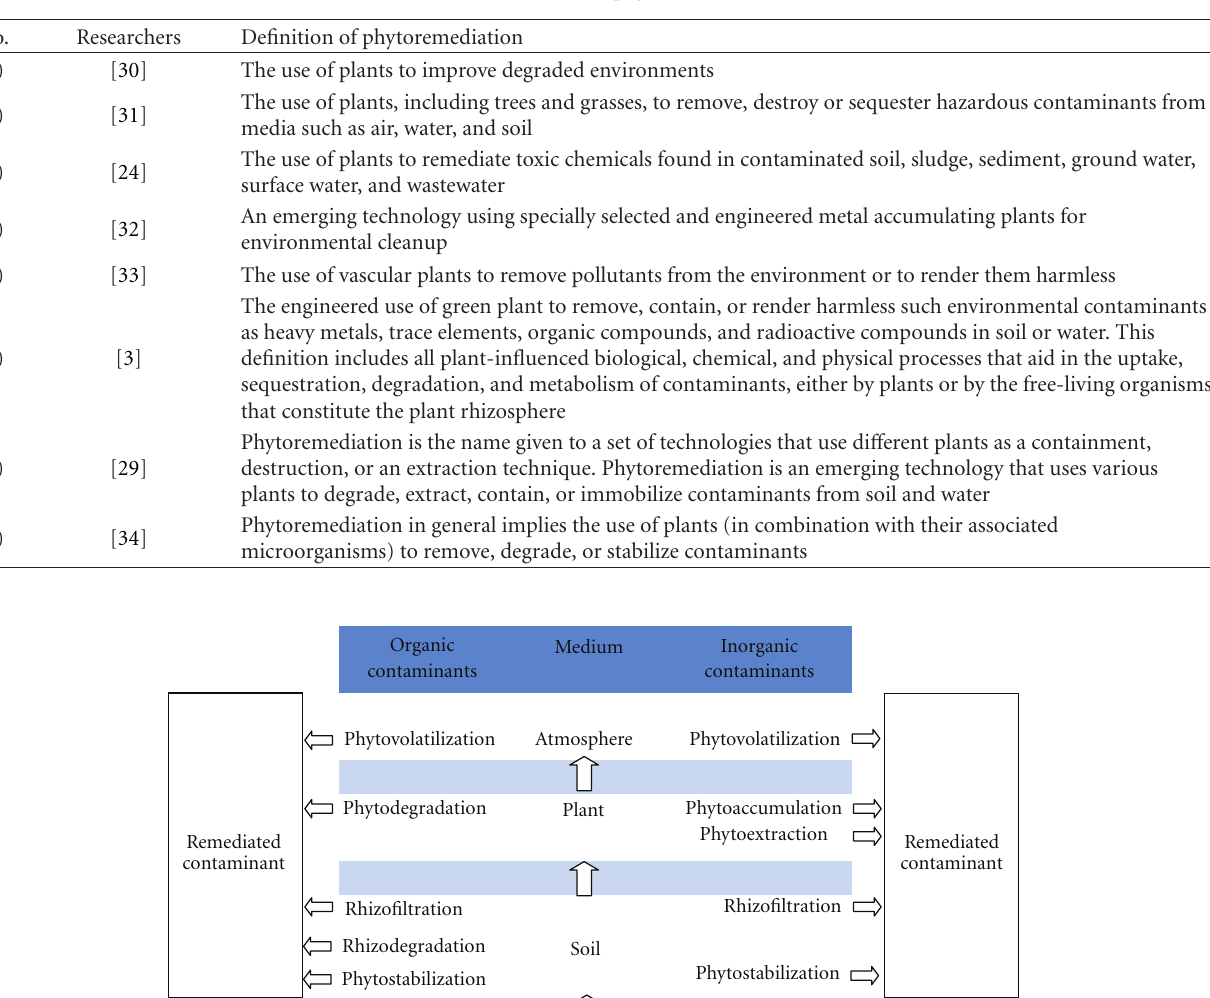
Table 1: Definition of phytoremediation.